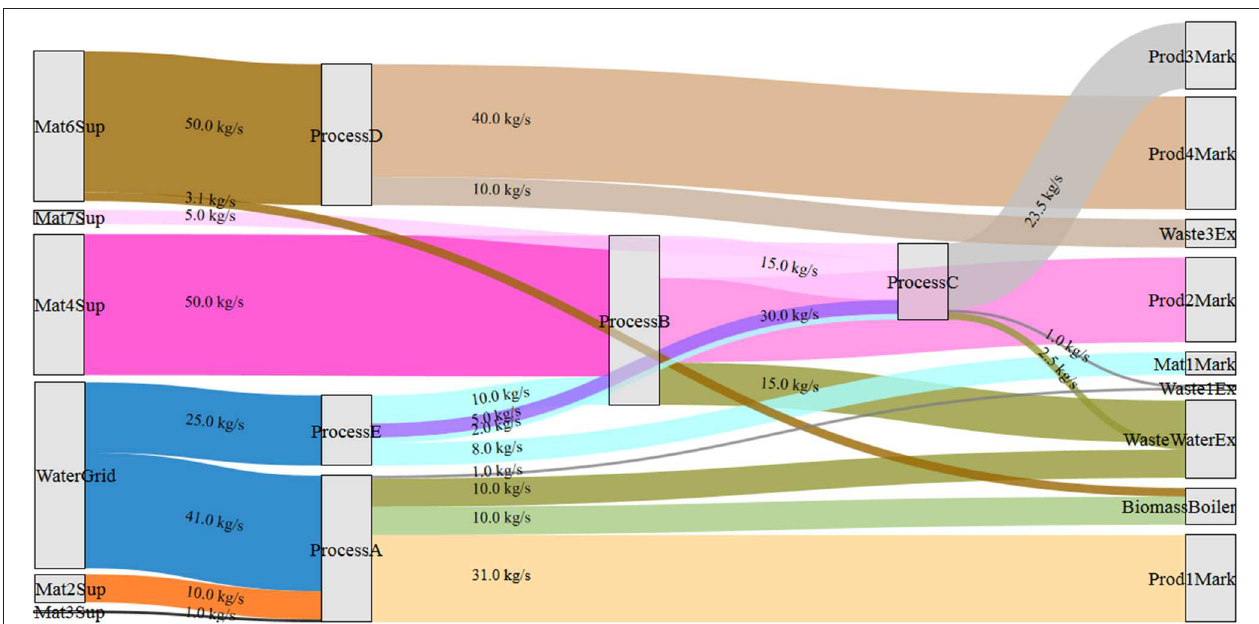
FIGURE 9 | Sankey diagram showing the resulting flows for environmental impact